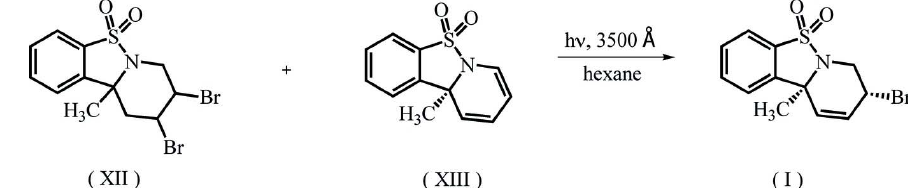
Figure 3 Photosynthesis of (I) from (XII) and